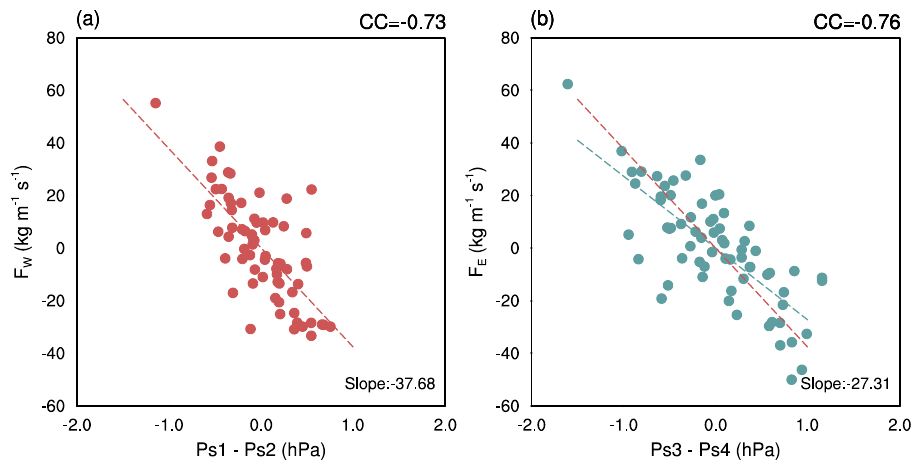
Figure 2. Relation between vertically integrated zonal moisture flux and meridional surface pressure difference. ( a ) The scatter between vertically integrated moisture flux at the western boundary ( F W ) and the surface pressure difference over regions Ps1 (15 ◦ –27.5 ◦ N, 50 ◦ –70 ◦ E) and Ps2 (5 ◦ S–10 ◦ N, 50 ◦ –70 ◦ E). ( b ) The scatter of vertically integrated moisture flux along the eastern boundary ( F E ) versus surface pressure variations over regions Ps3 (15 ◦ –27.5 ◦ N, 90 ◦ –110 ◦ E) and Ps4 (5 ◦ S–10 ◦ N, 90 ◦ –110 ◦ E). The correlation coefficient (CC) between zonal moisture flux and surface pressure difference is shown at the top of each panel.The red and blue lines are the least-square fit for the western and eastern boundary, respectively. This figure was created using NCL version 6.4.0 (https:// www. ncl. ucar.